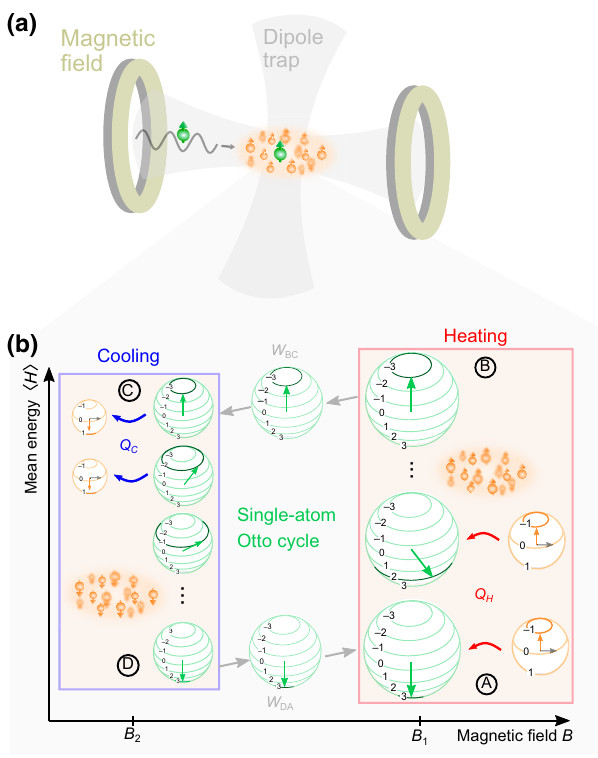
FIG. 1. The quasispin quantum Otto engine with the experi- mental setup. (a) The transport of a single Cs atom (green) into the ultracold Rb bath (orange) via an optical conveyor-belt lattice (sinuous line). Rb is trapped in an optical crossed-dipole trap, illustrated in gray. Magnetic field coils (yellow) control the mag- netic environment. (b) The cycle of our quantum Otto heat engine is made up of four strokes: heating via spin-exchange collisions with the Rb bath (A → B), which provides heat (cid:5) Q H (cid:2) ; compres- sion by a linear magnetic field ramp (B → C), decreasing the energy-level splitting of the Cs atoms; cooling via spin-exchange collisions with the Rb bath (C → D), which extracts heat (cid:5) Q C (cid:2) ; and compression by a second linear magnetic field ramp (D → A), which increases the energy-level splitting back to its initial value. In the figure, the m F states are shown as level schemes of green (Cs) and orange (Rb) spheres. The gray arrows in the Rb spheres indicate the m F = 0 state, which acts as the exhaust gas of our quantum heat engine.